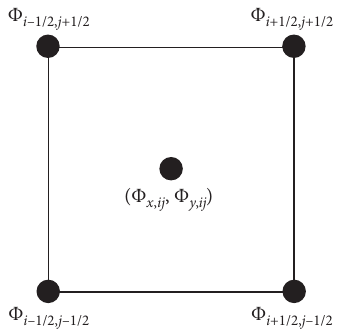
Figure 8: Fried geometry for the i , j ray. Wavefront gradient components Φ x,ij and Φ y,ij are obtained from (26) and serve to calculate wavefront phase Φ ij distribution.